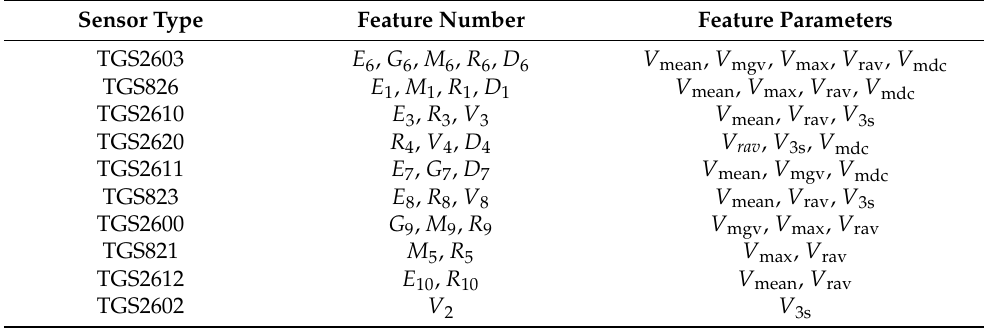
Table 9. The corresponding relationship between sensor model, feature number and feature parame- ters after GA-BP optimization. Sensor Type Feature Number Feature